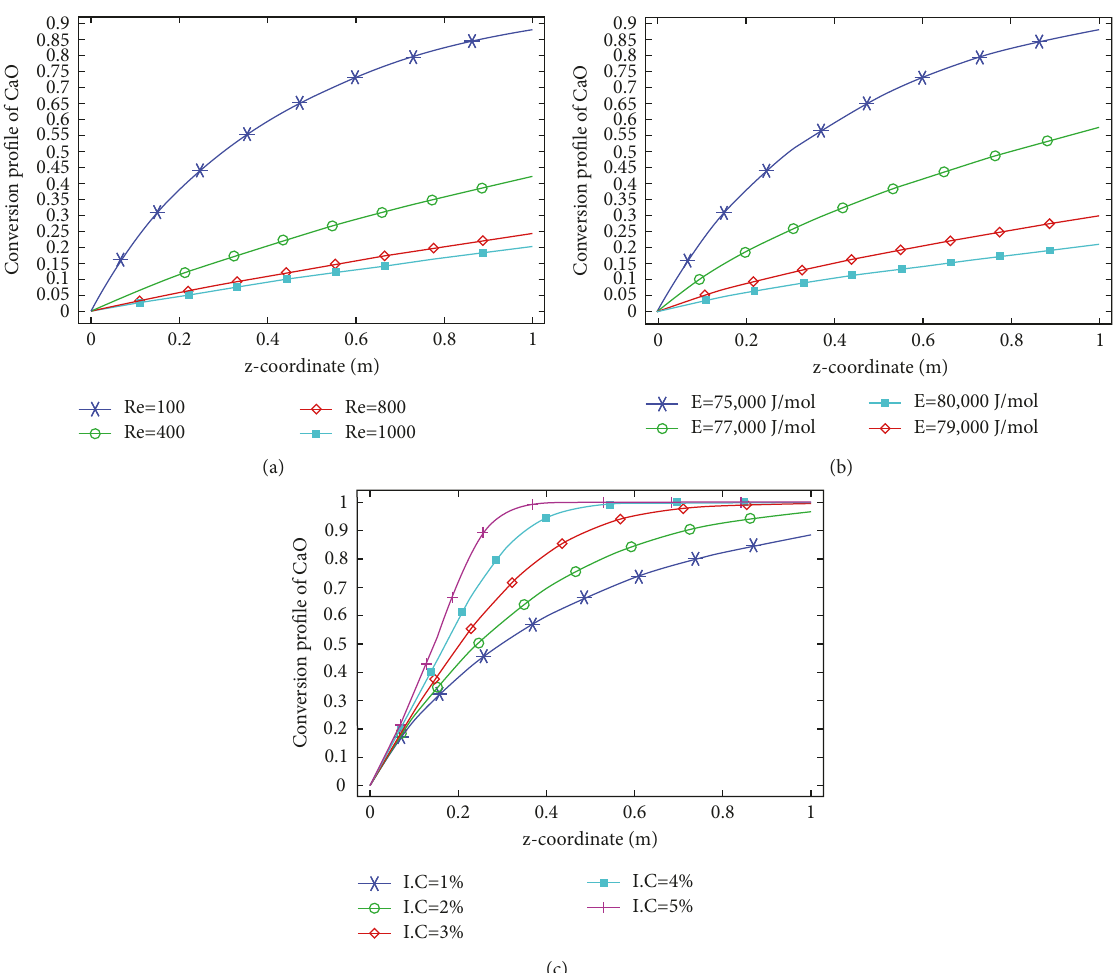
Figure 6: Conversion profile of CaO against the length of the reactor: (a) I.C � 1%, E � 75,000J/mol; (b) I.C � 1%, Re � 100; (c) Re � 100, E �